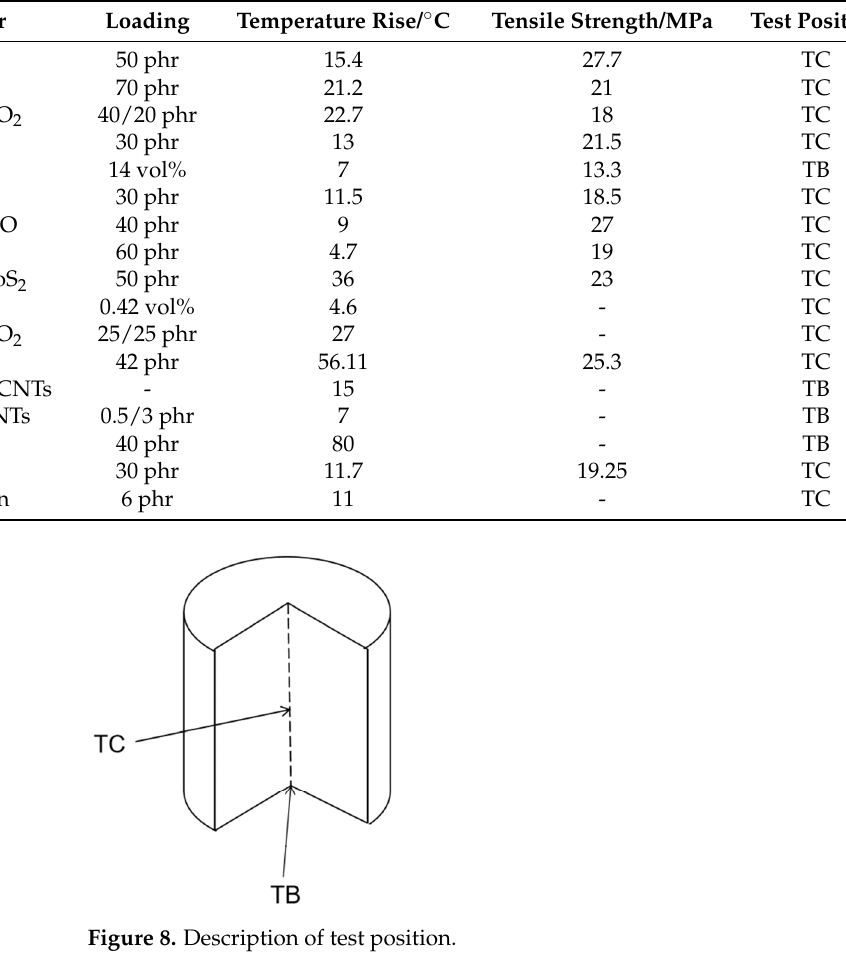
Table 1. Temperature rise of rubber nanocomposites.